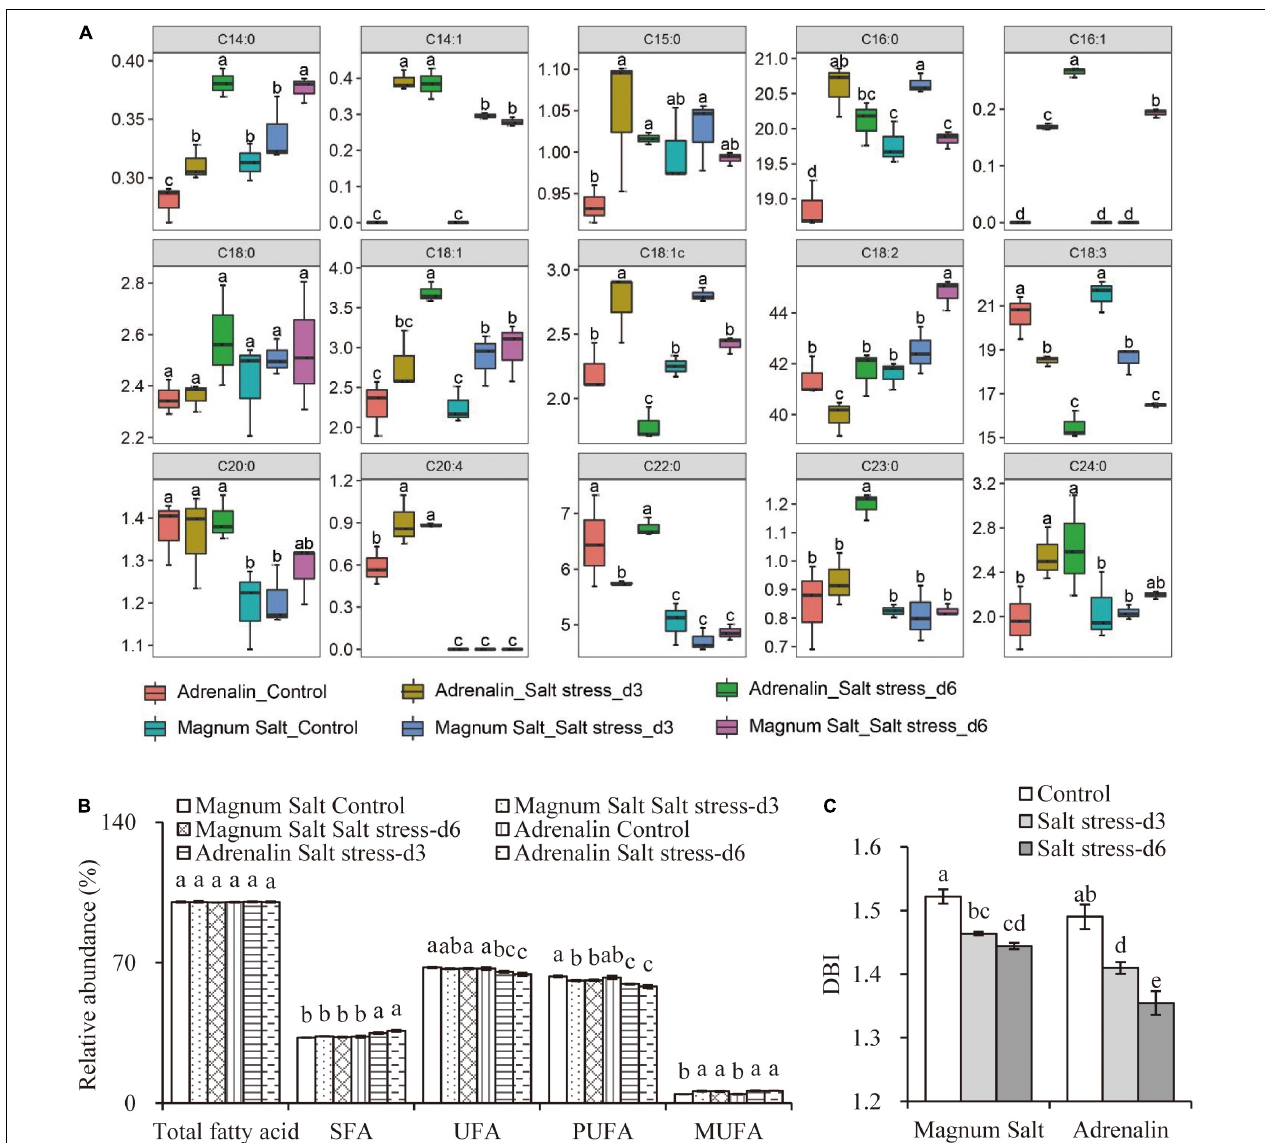
FIGURE 6 | Effect of salt treatment to the Fatty acids content in Magnum Salt and Adrenalin. Four-week old seedlings treated with 0 or 500 mM NaCl. At 0, 3 and 6 days, roots were sampled for fatty acids content analysis (A) . The upper and lower edges of the box in the boxplot represent the maximum and minimum values, respectively, and the horizontal line in the middle represents the median values. Relative abundance of saturated fatty acids (SFA), unsaturated fatty acid (UFA), monounsaturated fatty acids (MUFA), polyunsaturated fatty acid (PUFA); (B) and double bond index (DBI; number of double bonds per mole) (C) were calculated. Values are mean ± SE ( n = 3 replicates). Different letters indicate the significant differences ( P < 0.05, LSD) between two cultivars or